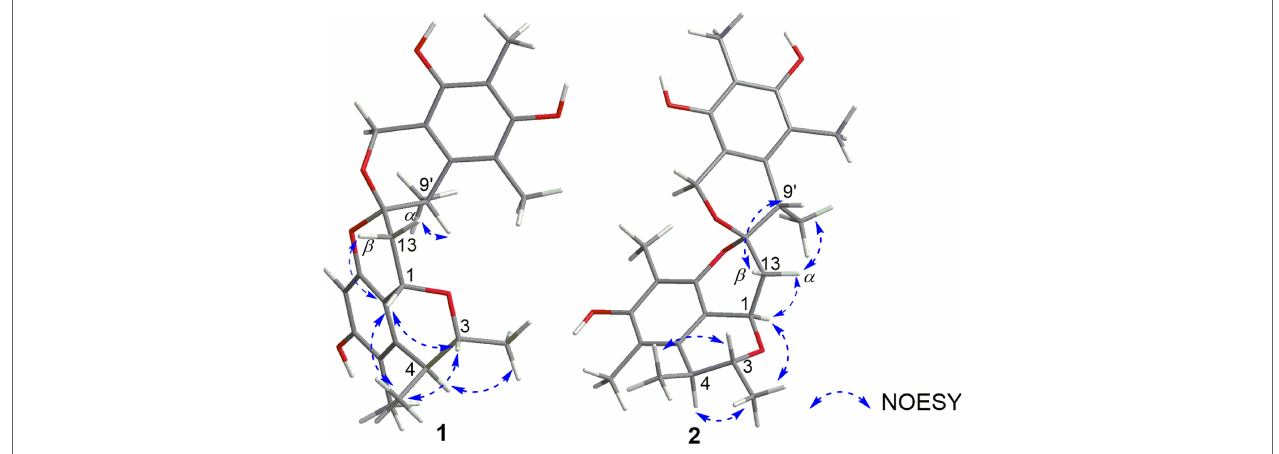
FIGURE 3 | Key NOESY correlations of compounds 1 and